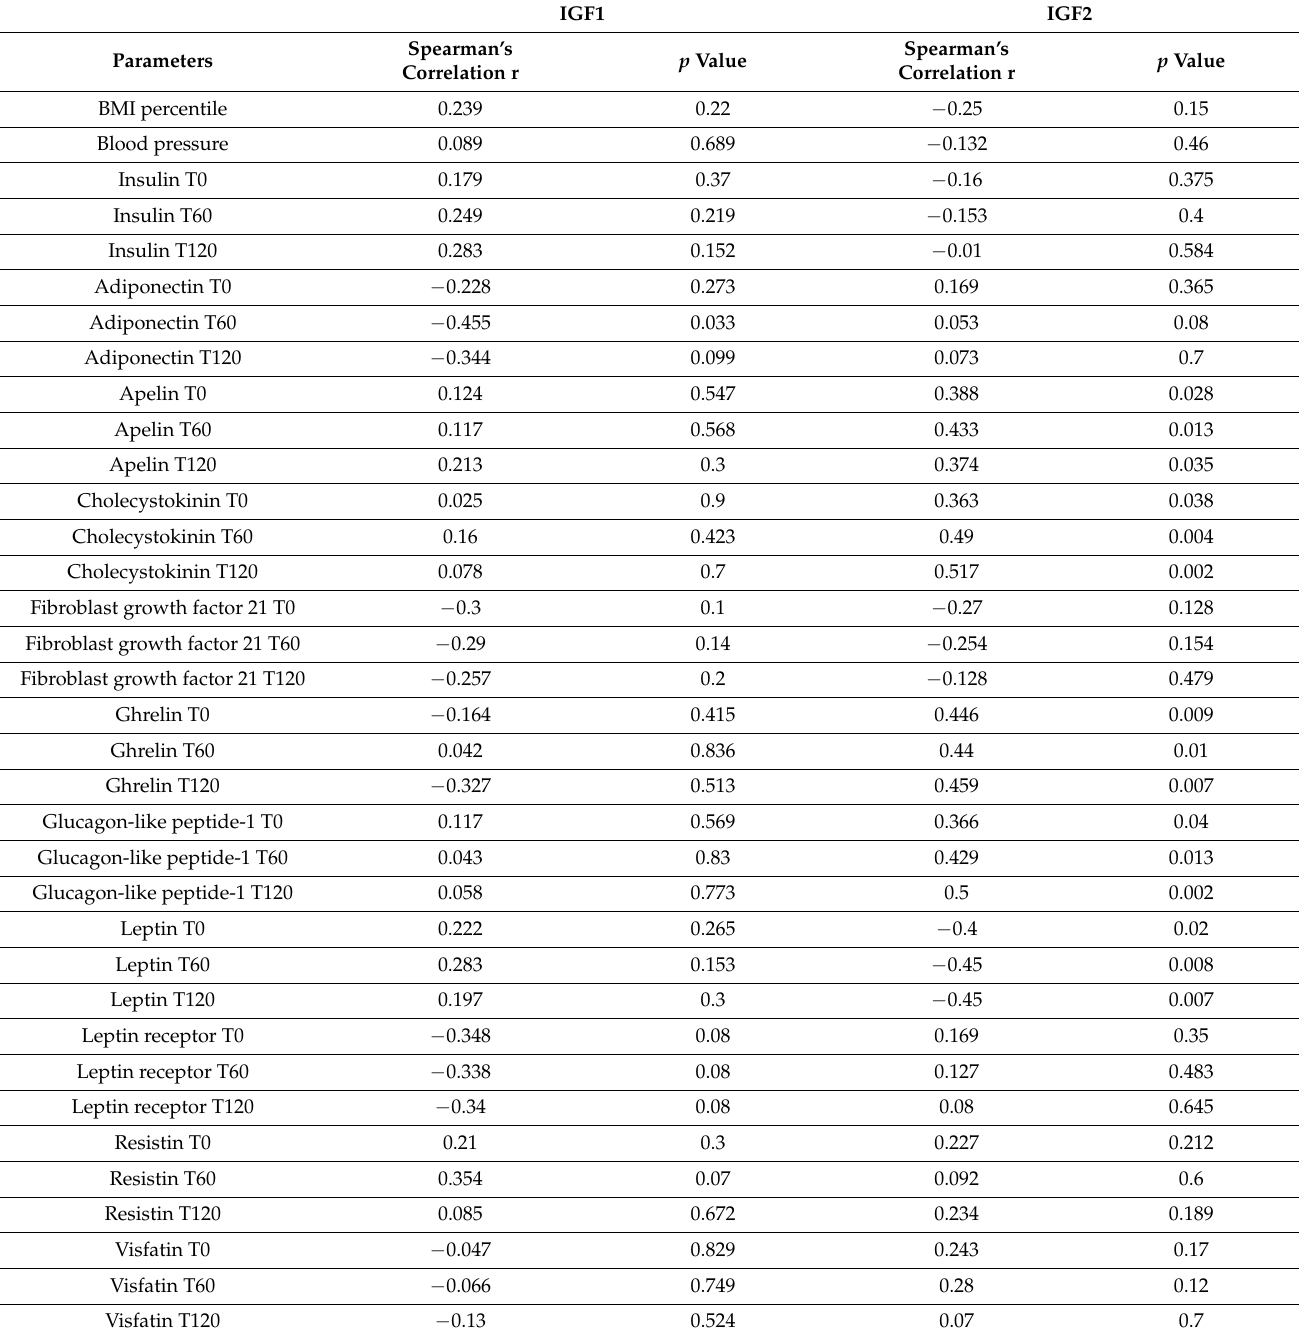
Table 4. Correlation results of IGF1 and IGF2 concentrations with selected metabolic